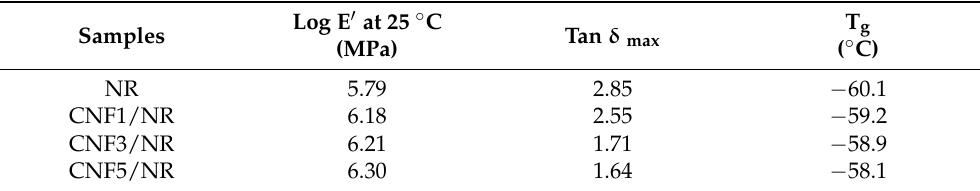
Table 4. Storage moduli (log E (cid:48) ) at 25 ◦ C, maximum tan δ peaks (tan δ max ), and glass transition temperatures (T g ) of the NR and the CNF/NR nanocomposites.